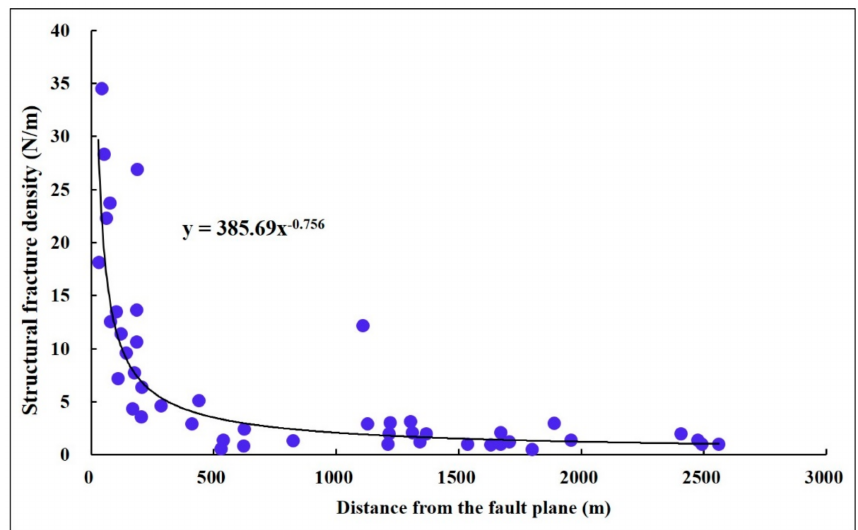
Figure 13. Relationship between fracture density and its distance to fault in the southwest of the Dongying Depression, Bohai Bay Basin. A part of data are taken from